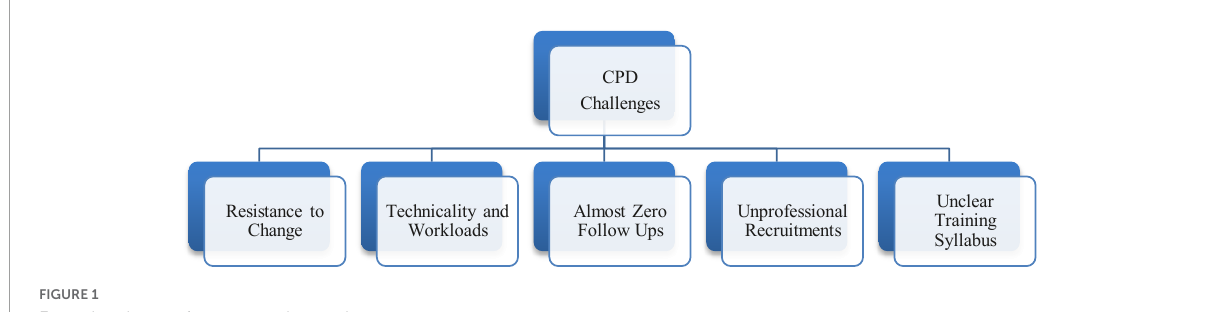
FIGURE1 Emerging themes from research question one.